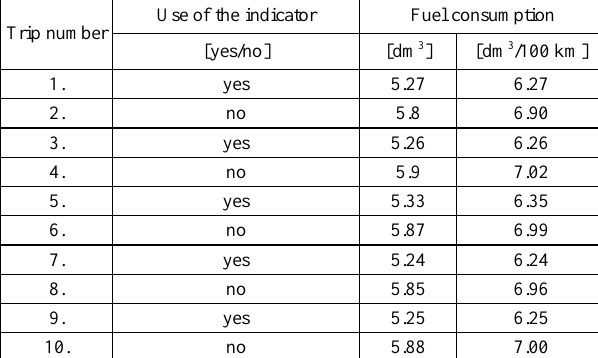
Table 2. Fuel consumption for individual trips of the